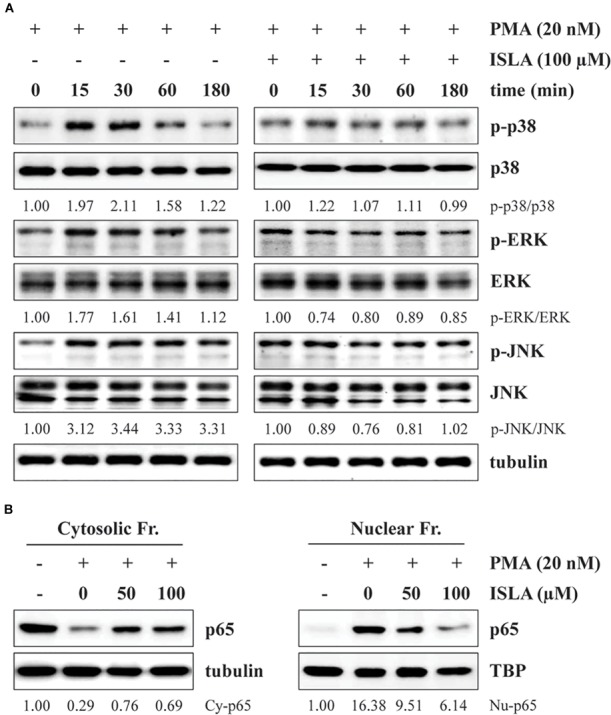
Isoliquiritin apioside inhibits PMA-induced MAPK and NF-κB activation in HT1080 cells. (A) Cells were pretreated with or without 100 μM ISLA for 12 h and then stimulated with 20 nM PMA for the indicated times. Total cell lysates were prepared and evaluated for MAPK activation using western blotting. The band intensities of phosphorylated p38, ERK, and JNK relative to the respective total protein levels were calculated using ImageJ software after normalization to tubulin expression. (B) Cells were pretreated with or without 50 and 100 μM ISLA for 12 h and then stimulated with 20 nM PMA for 30 min. Cytosolic and nuclear fractions were isolated, and the levels of the NF-κB p65 subunit were determined by western blotting. The relative intensities of the NF-κB p65 subunit in cytosolic and nuclear fractions were calculated using ImageJ software after normalization to tubulin and TBP expression, respectively. Data are representative of three independent experiments.